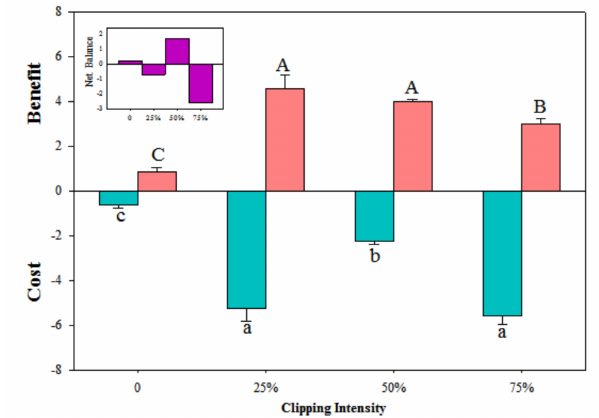
Figure 5. Compensation index with increasing clipping levels in di ff erent nutrient treatments. ( a ) H-L and H-H and ( b ) L-H and L-L indicate high-low, low-high, high-high and low-low nutrient treatments, respectively. The error bars represent standard errors (SE), and bars with di ff erent lower-case and upper-case letters indicate significant di ff erence among clipping levels for ramets with di ff erent nutrient treatments ( p < 0.05). *—significant di ff erence between high-low vs. high-high or between low-high vs. low-low at the same clipping level.